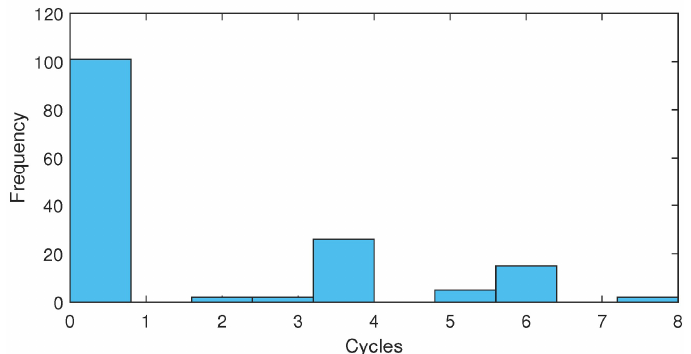
Figure 7. Sleep Cycles During Experiment Bad Habits.